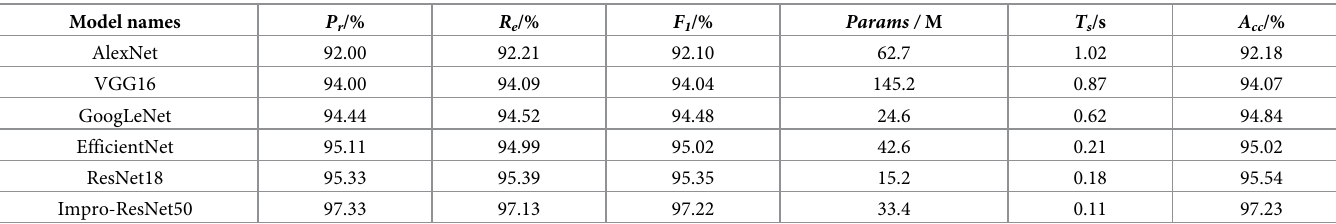
Table 4. Comparison of test results for different model cotton